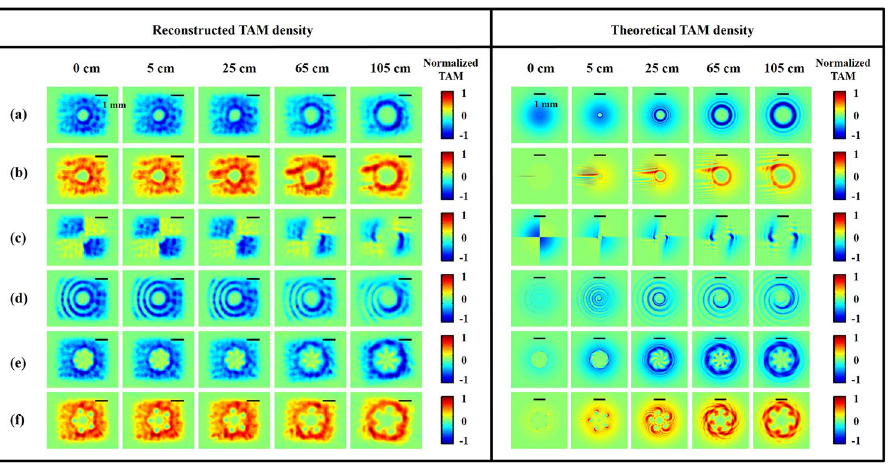
Figure 7. Spatial TAM density distributions of modulated beams on different cross sections. Left: DH reconstructed results; right: simulation results. Each case corresponds to that in Fig. 2. The color bar shows the normalized quantity of TAM densities in units of Ns / m 2 . The scale bar at the top in each figure is about 1